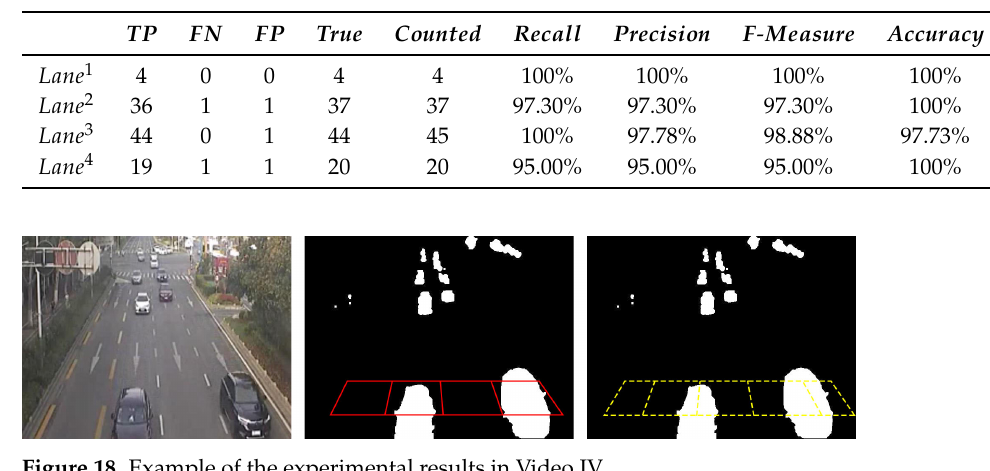
Figure 18. Example of the experimental results in Video IV. Table 13. Experimental results of Video